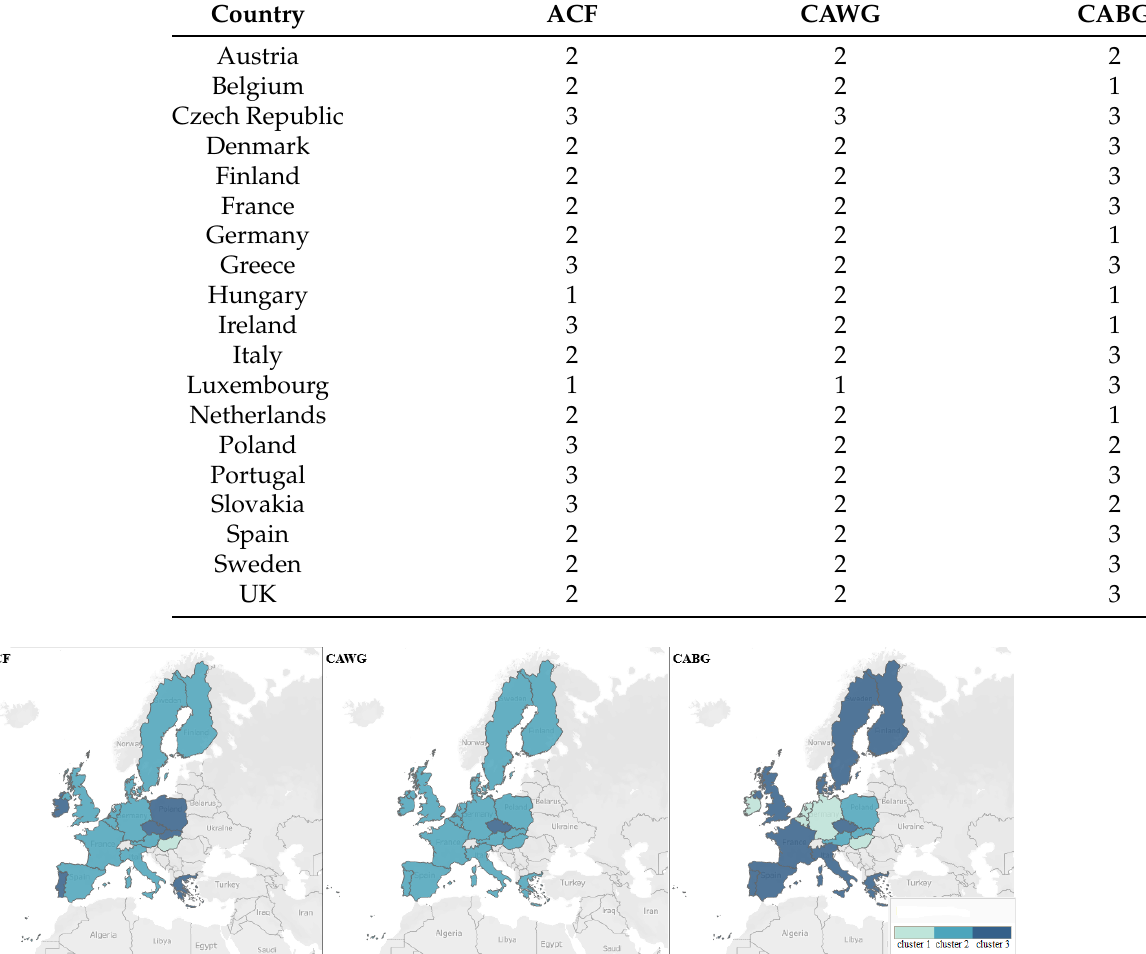
Table 3. Countries classification.